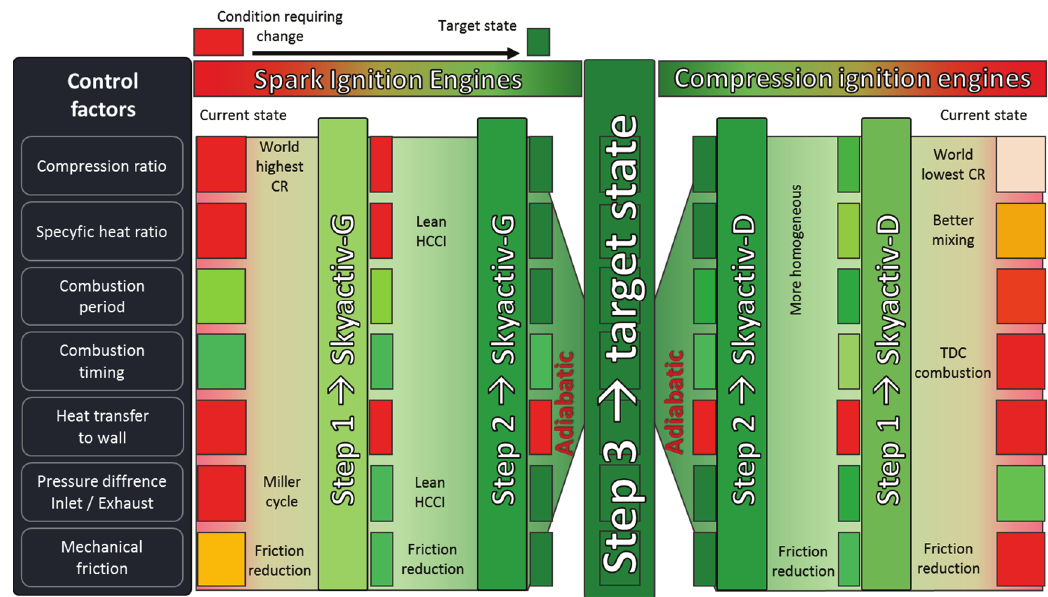
Fig. 1. The concept of complete modernization of internal combustion engines; CI and SI engines striving for common construction